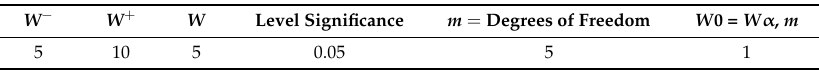
Table 12. Parameters for the statistical test.